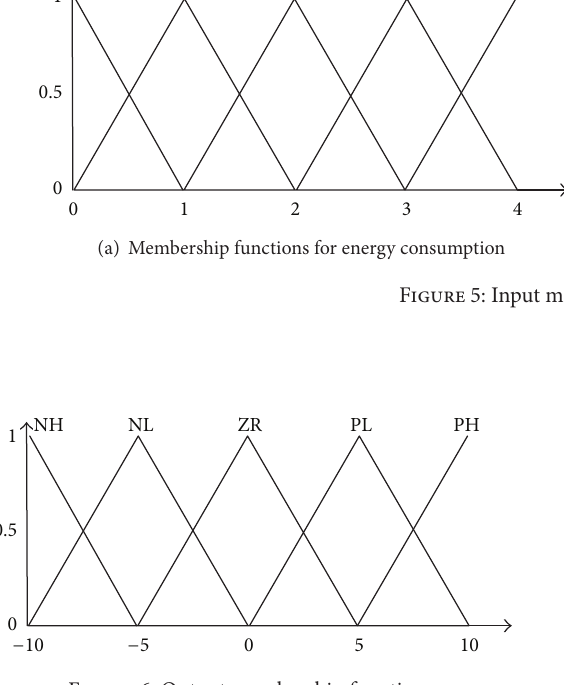
Figure 6: Output membership functions.